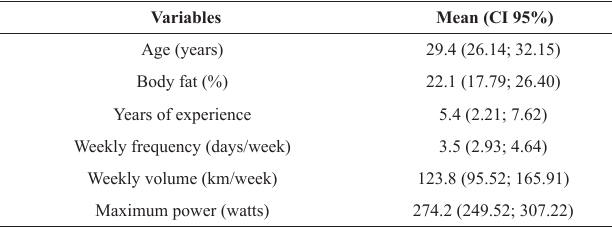
Table 1 - Description of sample characteristics and exercise session (n = 16)